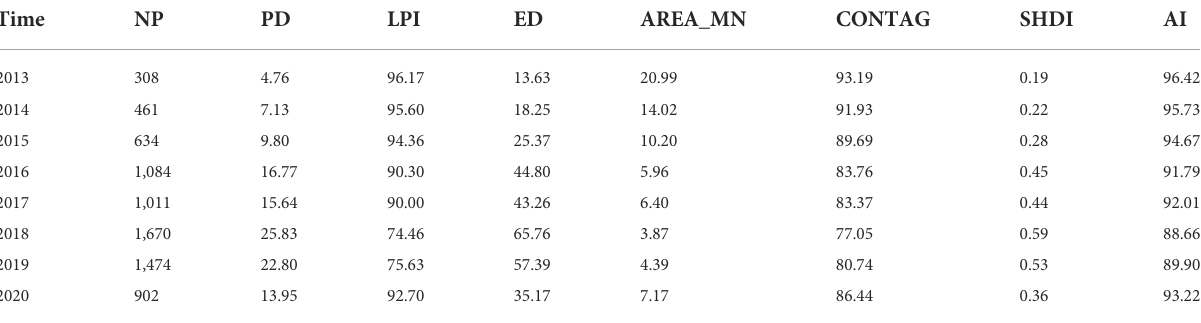
TABLE 10 Ecological Landscape Index of Jiuzhaigou Scenic Area from 2013 to